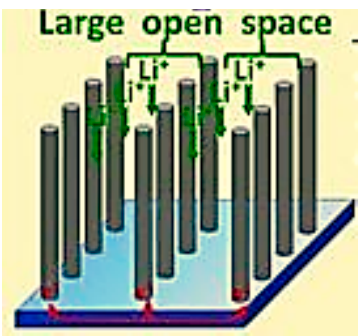
Figure 7. Self-supported Li 4 Ti 5 O 12 nanowire arrays with high conductivity architectures.